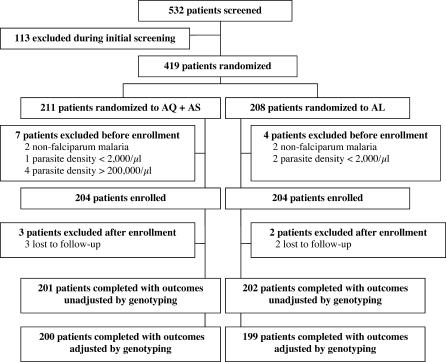
Trial ProfileAQ + AS, amodiaquine + artesunate; AL, artemether–lumefantrine.